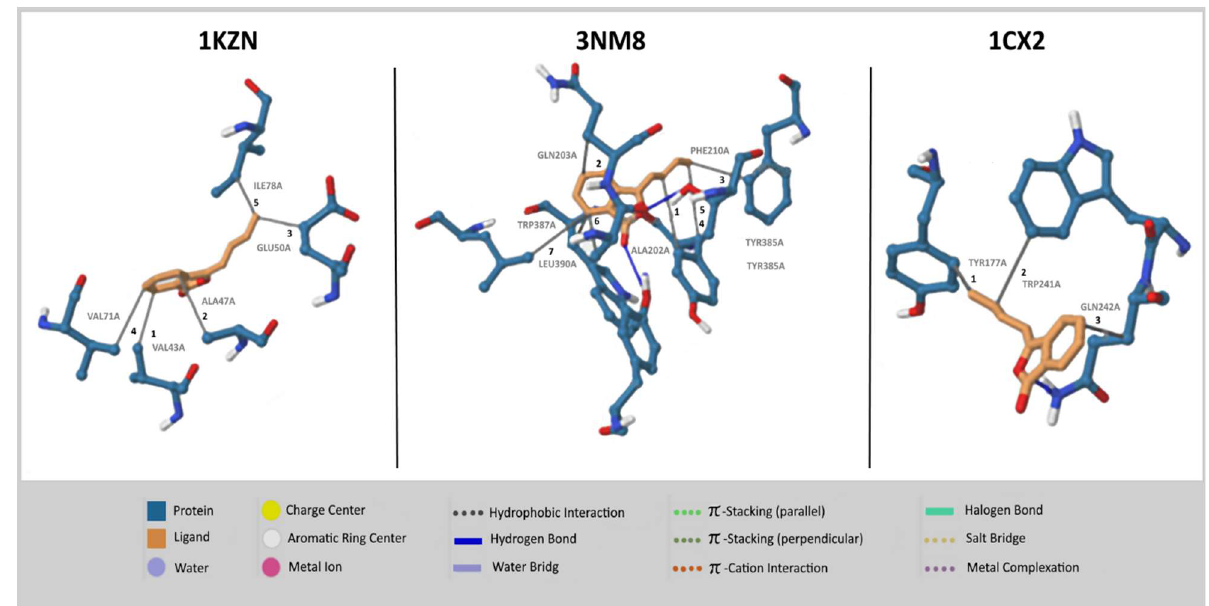
Figure 7. Interaction of 1kzn, 3NM8 and 1CX2 protein with isocnidilide inhibitor. Table 4. The binding energy and Hydrophobic Interactions for isocnidilide drugs with target proteins. Protein